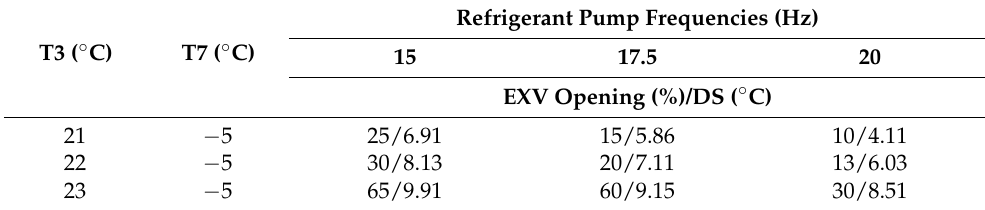
Table 1. EXV opening and corresponding DS at three refrigerant pump frequencies.